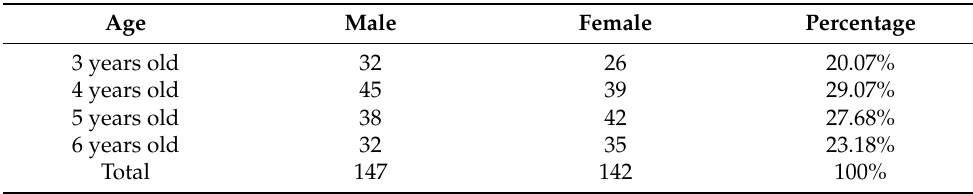
Table 1. General information.